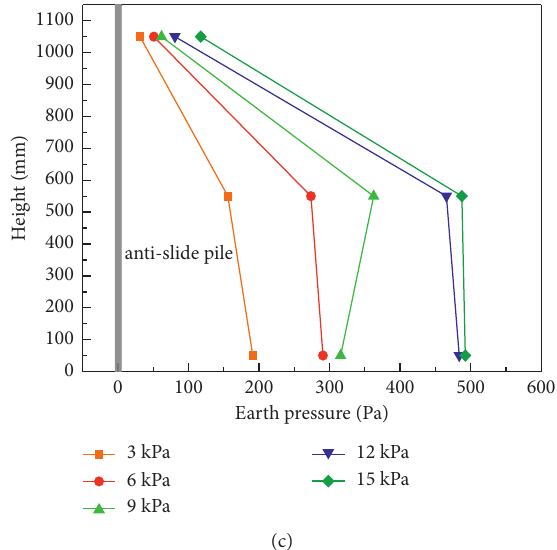
Figure 23: Earth pressure in front of pile: (a) P1; (b) P4; (c)